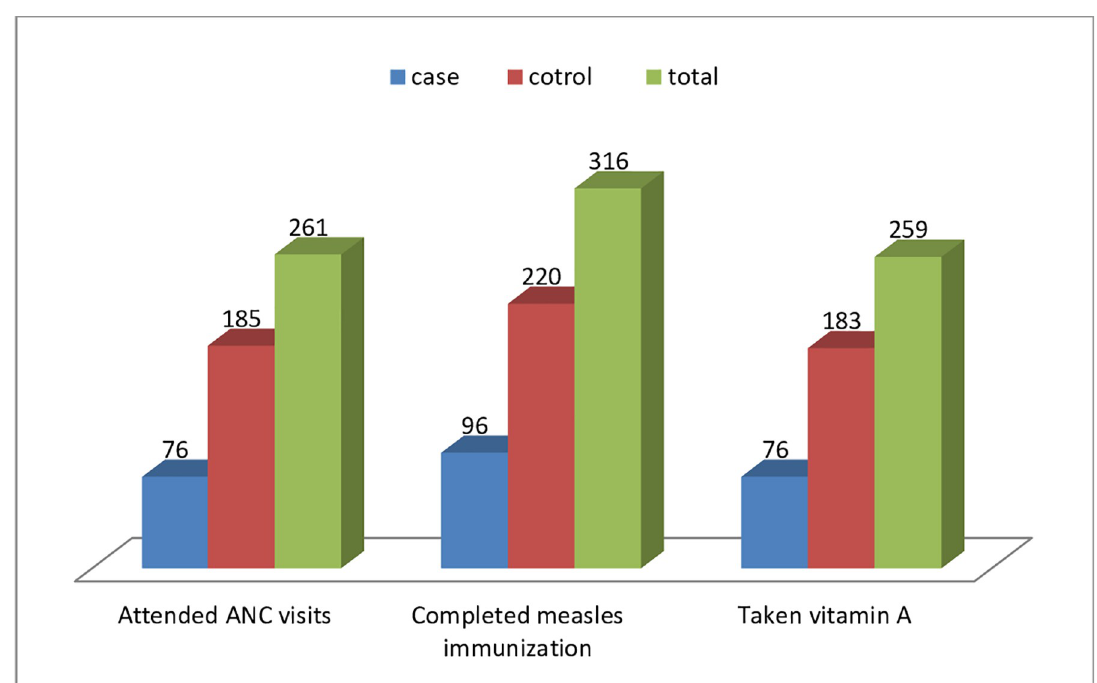
Fig 2. Health service utilization characteristics of children aged 6–59 months in Wonago Woreda, South Ethiopia November 2018.